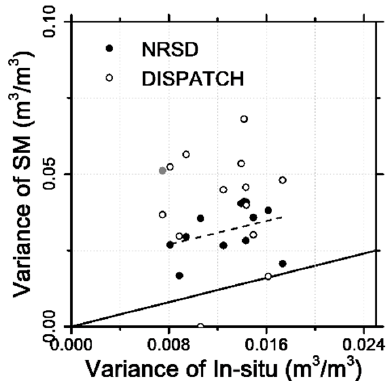
Figure 7. Variance of disaggregated soil moisture versus variance of in situ soil moisture. The bold solid line denotes the 1:1 line, and the dashed line denotes the linear trend of the variance of NRSD soil moisture relating to the in situ trends. DOY 256 (gray point in the figure) was forcibly excluded from fitting for its abnormality because more ancillary meteorological data are required to study that variable.